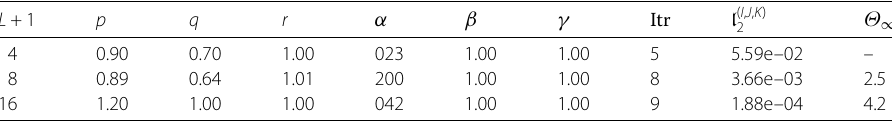
Table 5e Errors and order for EF-EEG-TOCS in Example 5.5 at (cid:2) =